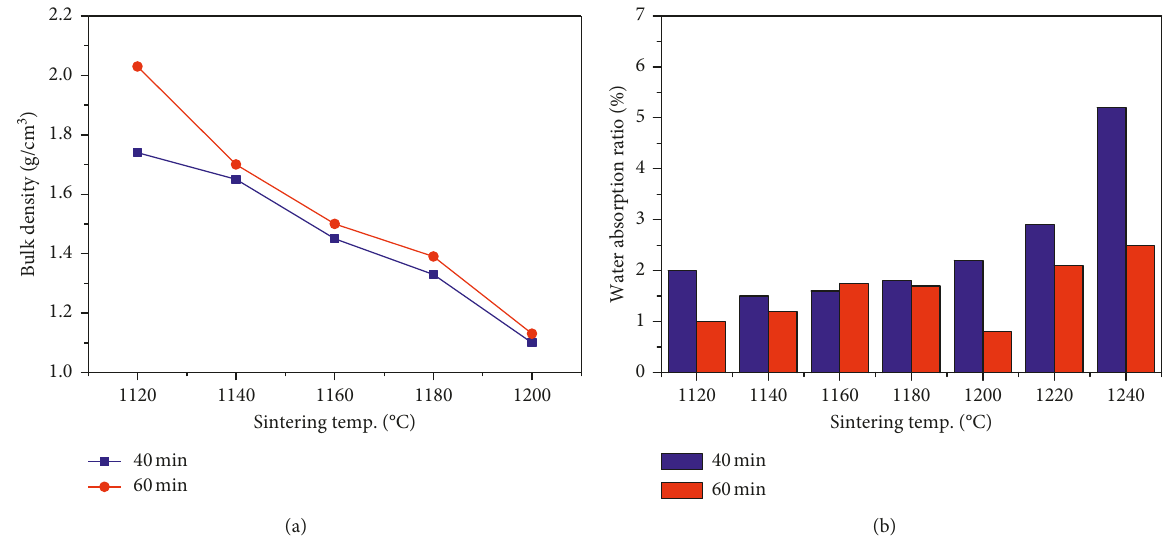
Figure 8: Physical properties of the lightweight aggregate by normal sintering. (a) Bulk density. (b) Water absorption